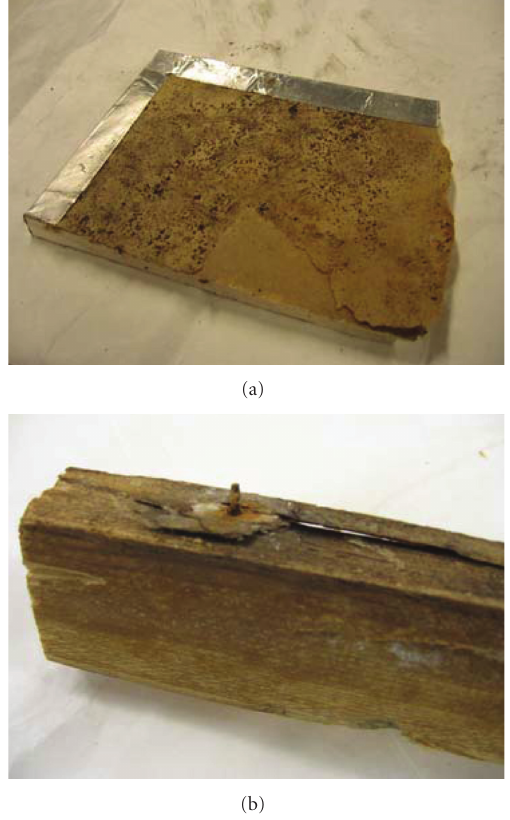
Figure 1: Large field samples from where smaller samples have been collected for the FTIR measurements. Mould fungi on GU plaster board (a) and mould fungi on wood and wood rot (b). GU: exterior grade gypsum board (“outdoor